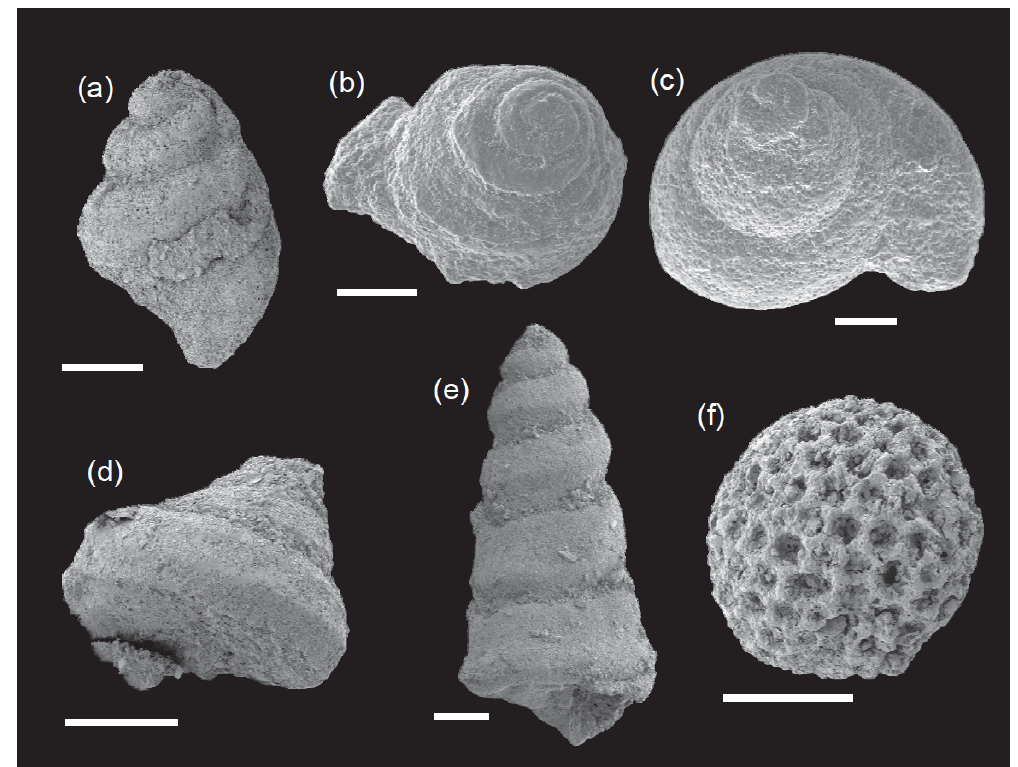
Figure 14. (a–e) Ferruginous moulds of microgastropods. (f) Radiolarian. Scale bar: